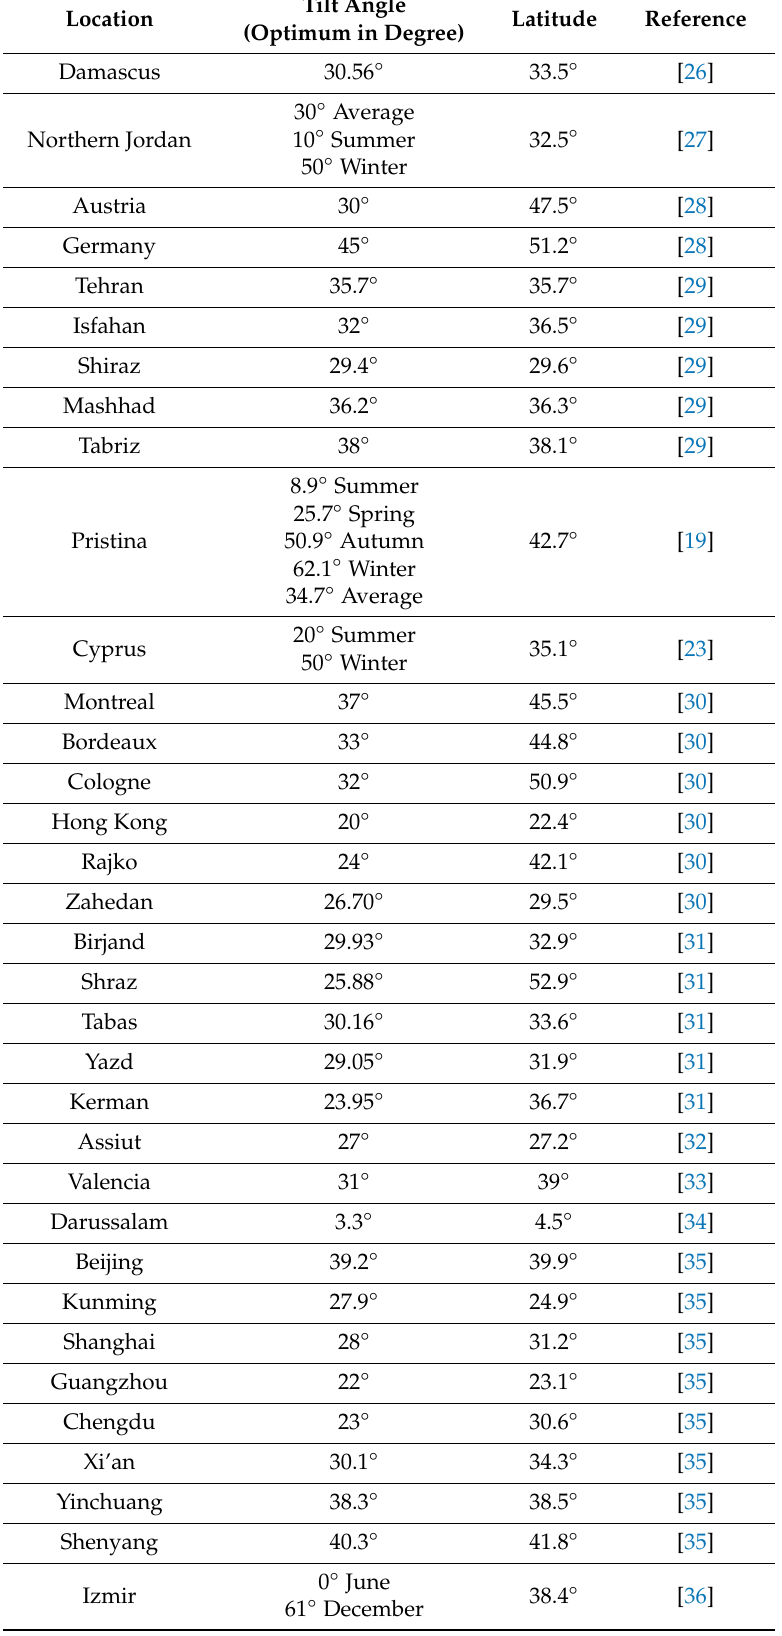
Table 1. Optimal tilt angle results in di ff erent regions of the world.